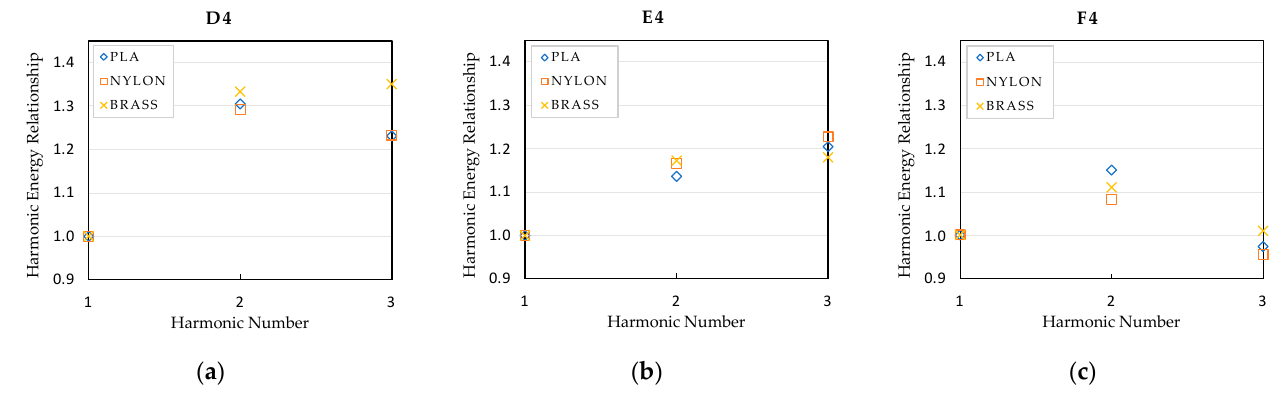
Figure 13. Harmonic energy relationship of the high register notes: ( a ) F2 note; ( b ) G2 note; ( c ) A2 note.